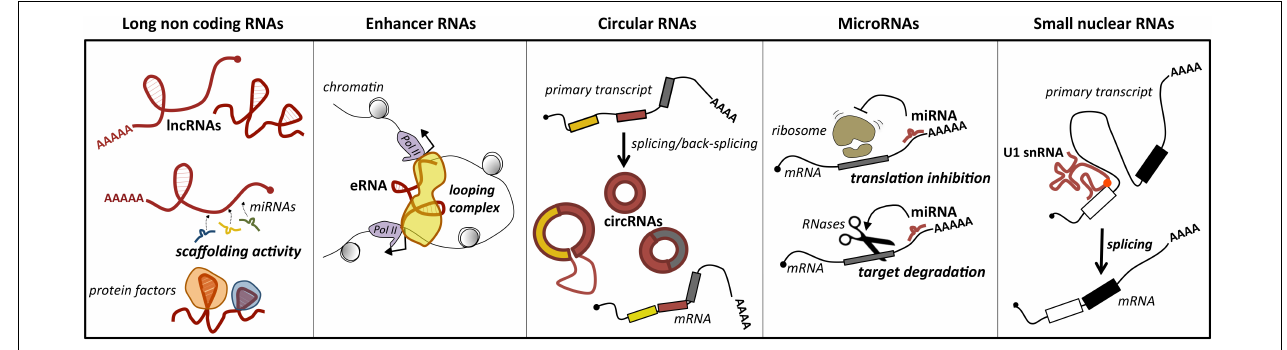
FIGURE 1 | Main classes of ncRNAs implicated in MB. For each class, the predominant activity is depicted: lncRNAs act as scaffolds for microRNAs (ceRNA function) or protein factors, which affects their activity; enhancer RNAs (eRNAs) may have a pivotal role in promoting mRNA transcription by facilitating enhancer–promoter interaction; circular RNAs (circRNAs), for their biogenesis from a non-canonical splicing event, may have a role in the control of mature mRNA levels, or additional functions as miRNA or protein decoys; miRNAs by direct pairing with their mRNA targets trigger their translation inhibition or degradation; small nuclear RNAs, as components of the ribonucleoprotein machinery operating the splicing, may control this reaction underlying gene expression. The position of U1 snRNA mutation identified in MB is indicated by a red